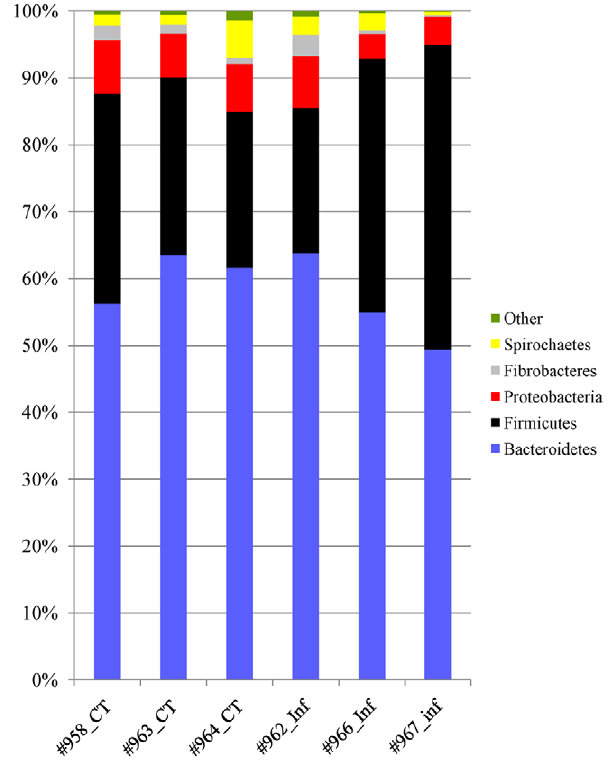
Figure 4. The relative distribution of the five most abundant phyla in the bovine abomasal microbiota of immune animals. The number denotes percentages of 16S sequences assigned to a given phylum using RDP Classifier at an 80% confidence threshold. CT: control; Inf: infected.